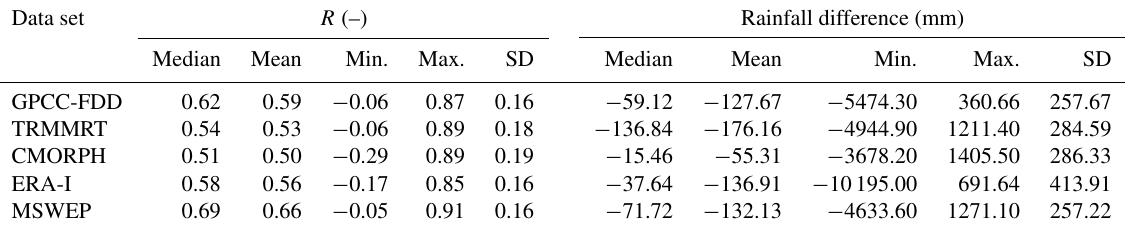
Table 4. Statistical summary of correlation coefficient ( R ) and difference in mean rainfall for the analyzed data sets against SM2RAIN-CCI during the period 2000–2013. For each score, the median, mean, minimum, maximum and standard deviation values are reported.